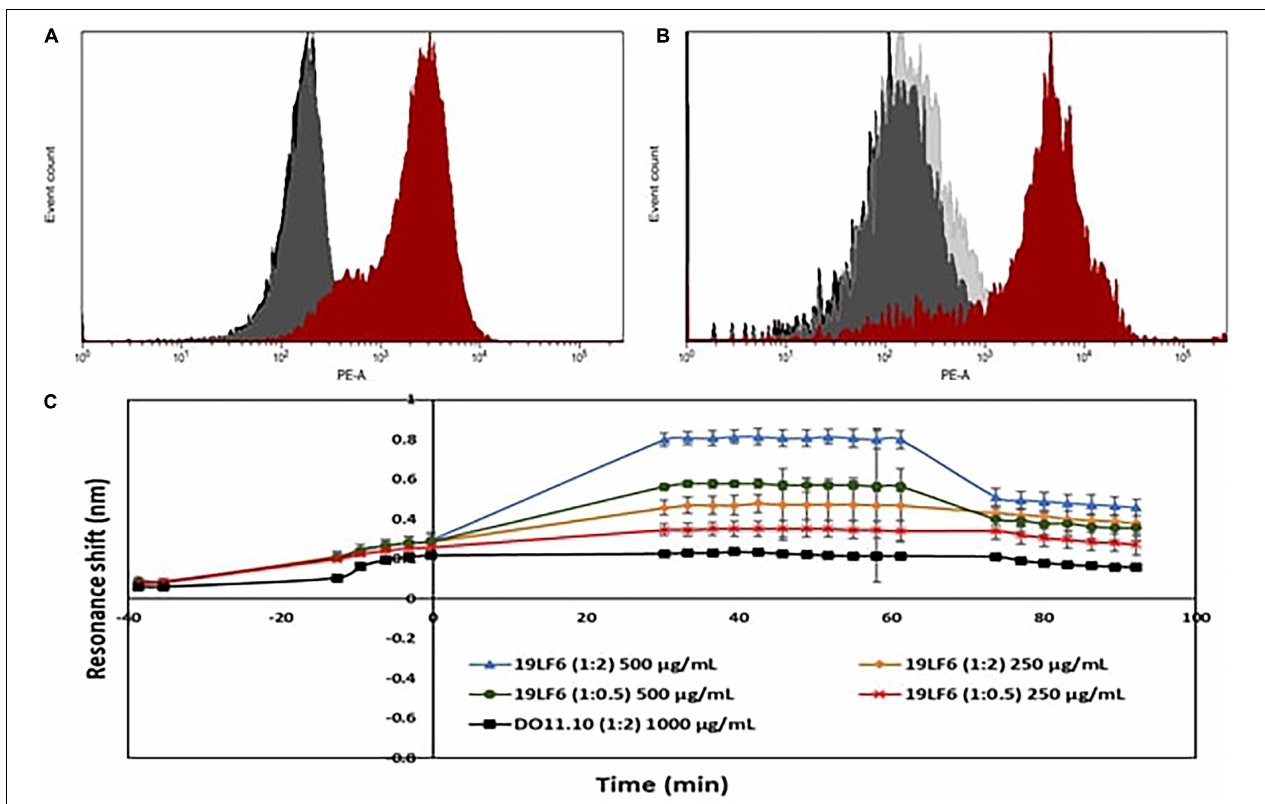
FIGURE 2 | Validation of TCR on T-MNPs. (A) Histogram curves demonstrate 19LF6 cells expressing the TCR β chain. 19LF6 cells were stained with either mouse IgG (isotype) or anti-TCR antibody. Unstained, isotype, and stained groups are represented as black, gray, and red curves, respectively. (B) T-MNPs also expressed the TCR β chain [19LF6 MNP’s were stained with either mouse IgG (isotype) or anti-TCR antibody]. Unstained, isotype, and stained groups are represented as black, gray, and red curves, respectively. Histograms were analyzed using BD LSR II with no threshold on the forward scatter to detect the nanoparticles. (C) Binding kinetics of D-MNPs (non-specific control), T-MNPs (our treatment group) and NNPs (negative control) at varying concentrations and NP to membrane protein (w/w) ratios; kinetics were measured in terms of resonance shift over a period of time using ResoSens label-free optical